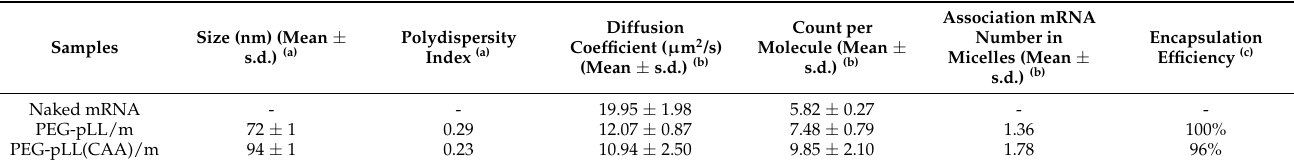
Table 1. Characteristics of PEG-pLL and PEG-pLL(CAA)-based micelles.